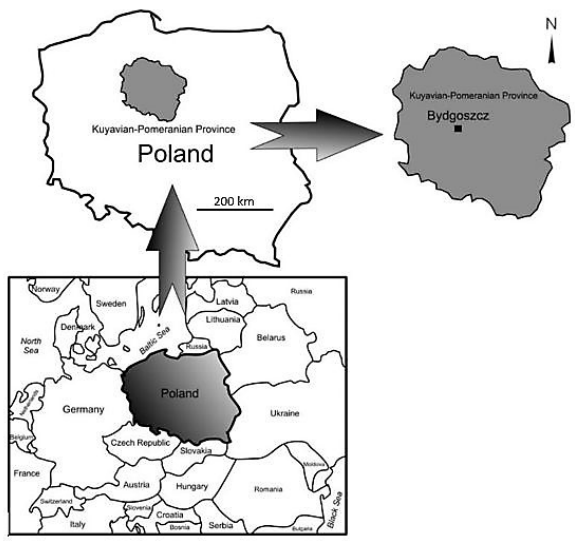
Figure 1. The geographical position of the Bydgoszcz region for which the research was con- ducted.